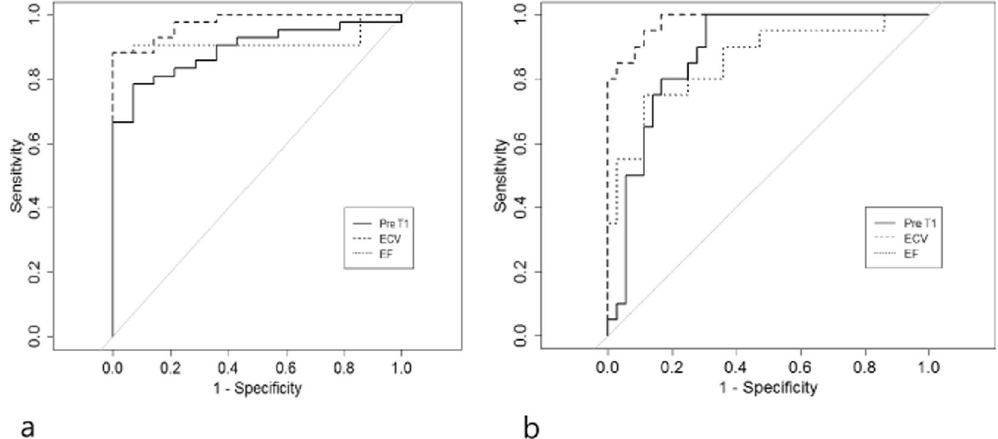
Figure 5. Receiver operating characteristic (ROC) curves for diagnosis. ( a ) Areas under the ROC curves (AUCs) for the extracellular volume (ECV), native T1, and left ventricle ejection fraction (LVEF) in post- modelling subjects were 0.974 (95% confidence interval, 0.955–0.989), 0.893 (0.848–0.930), and 0.916 (0.874– 0.951), respectively. ( b ) In 12- and 16-week modelling subjects, the AUCs for the ECV, native T1, and LVEF were 0.981 (0.969–0.990), 0.882 (0.855–0.910), and 0.857 (0.801–0.906),